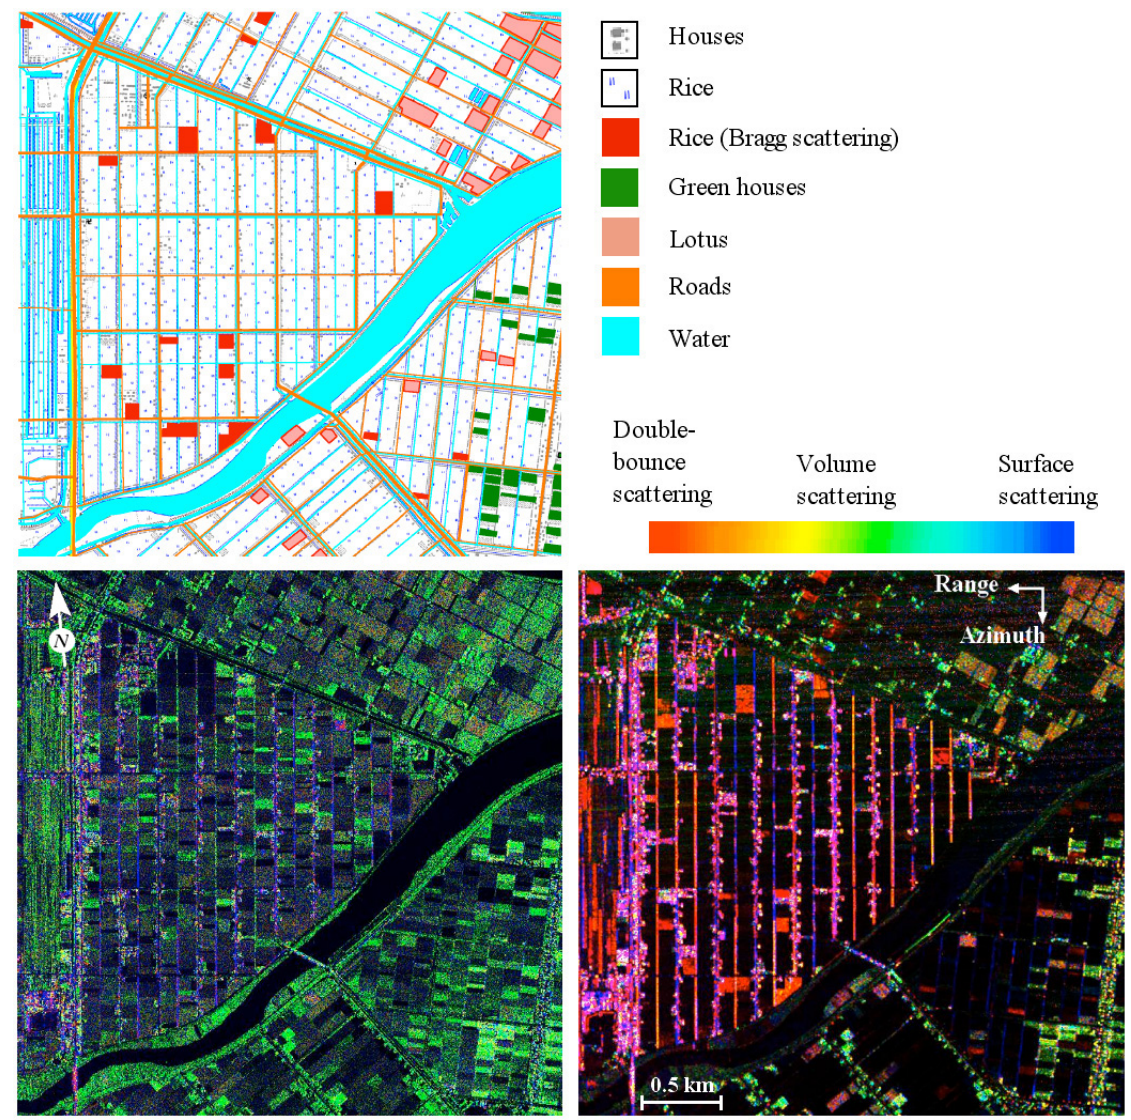
Figure 15. Airborne Pi-SAR X-band (bottom-left) and L-band (bottom-right) images decomposed into three scattering powers with approximate scene center at (N: 34.57 ◦ , E: 133.90 ◦